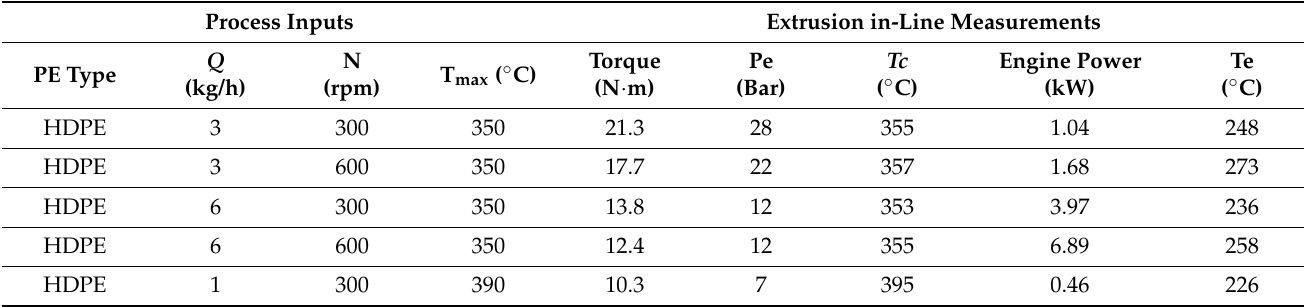
Table A1. In-line measurements for the different tested extrusion